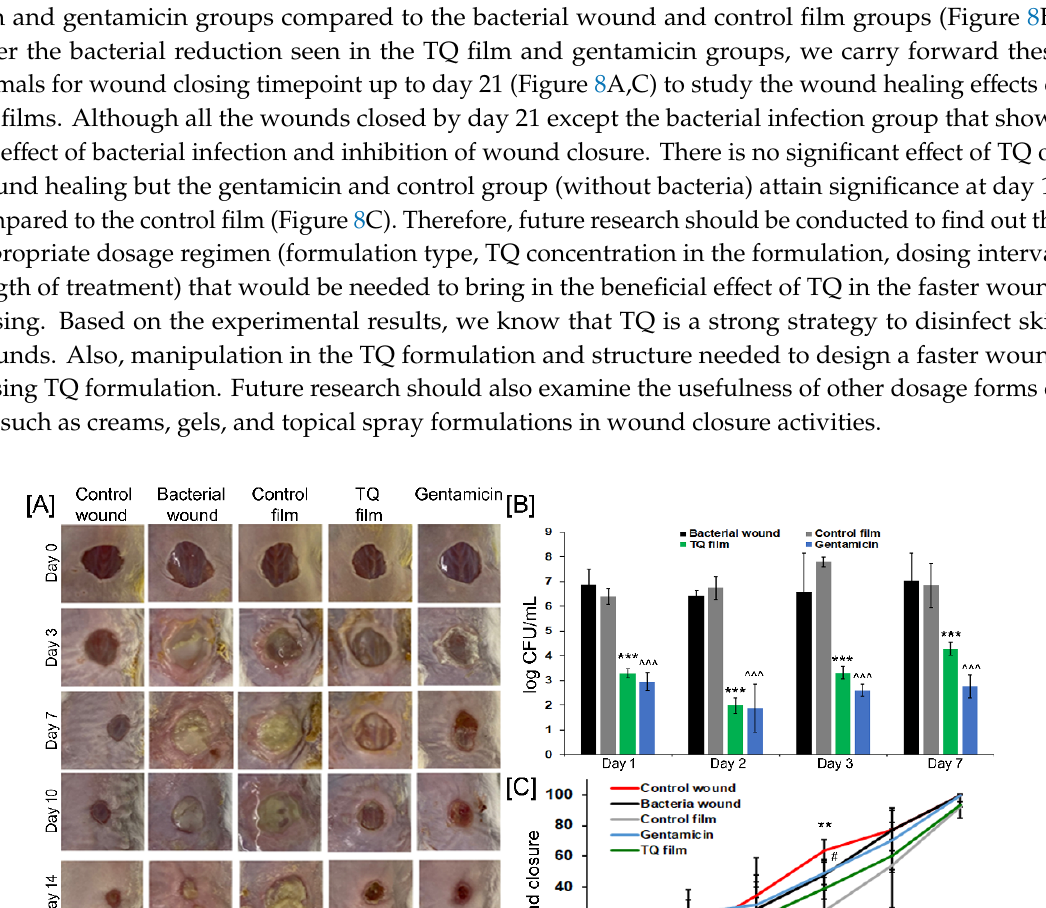
16 of 19 Figure 7. Effect of TQ treatment on the wound healing of keratinocytes using scratch assay. ( A ) Representative micrographs (10×) from Control (+Ve), Control, 1 ng/mL, and 100 ng/mL of TQ showing the original wound at day 0 and the wounds after 3 and 6 days of keratinocyte cell migration; ( B ) Quantitative analysis of wound closure as a function of time. The wound area was determined as the wound area at a given time relative to the original wound area at day 0 ( n = 5–6). *** p < 0.001 (Control vs. Control + Ve), ^^ p < 0.01 (Control vs. 1 ng/mL) and ### p < 0.001 (Control vs. 100 ng/mL). 3.9. Anti-Bacterial and Wound Healing Activity of TQ Film In Vivo